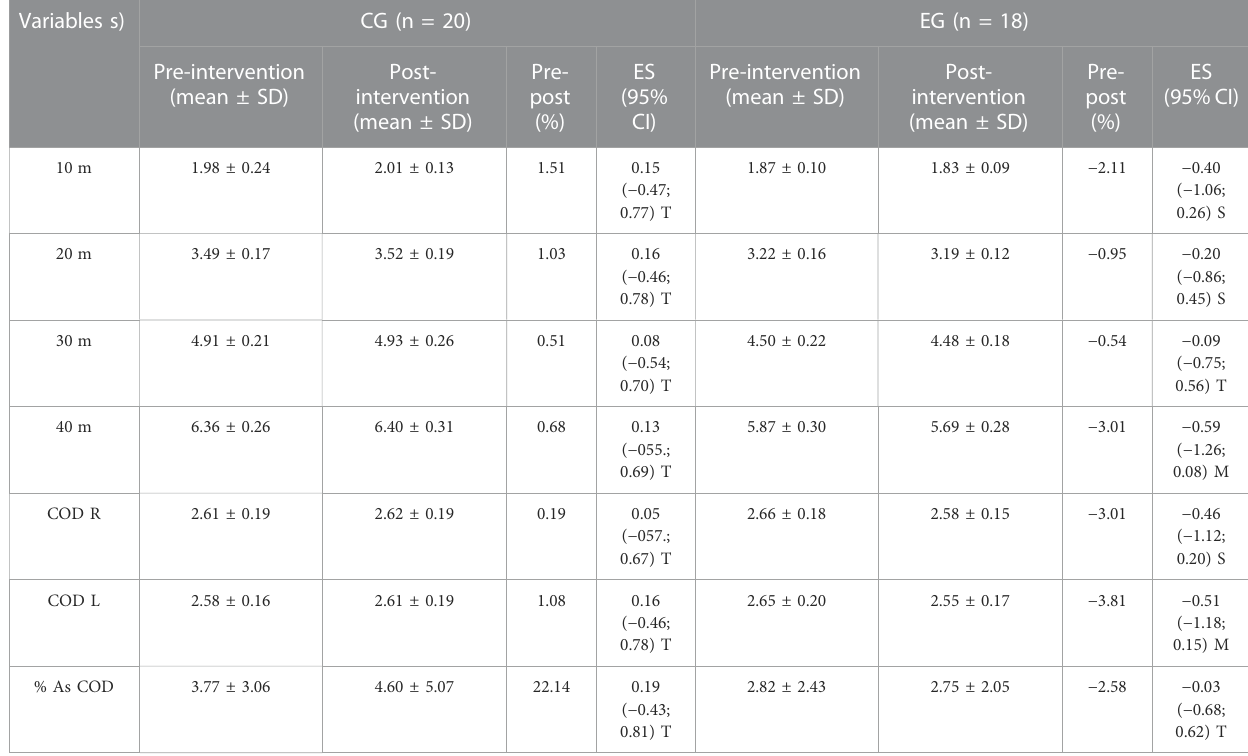
TABLE 3 Results of sprint and change of direction variables in control and experimental group. Variables s)